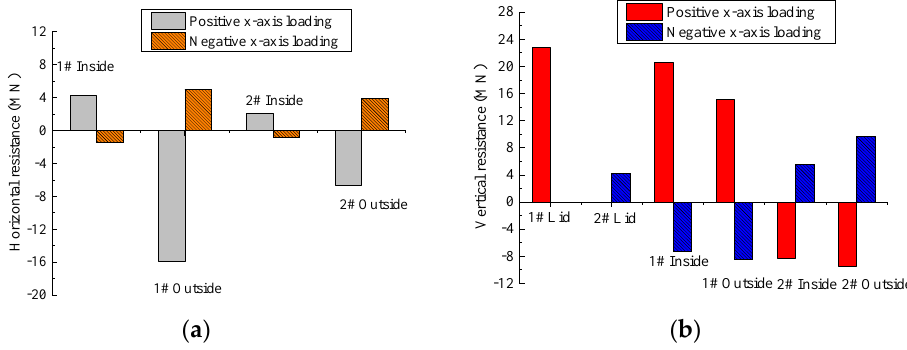
Figure 18. Horizontal and vertical resistance of each part of the buckets of TBJF under ultimate horizontal load. ( a ) horizontal resistance, ( b ) vertical resistance.